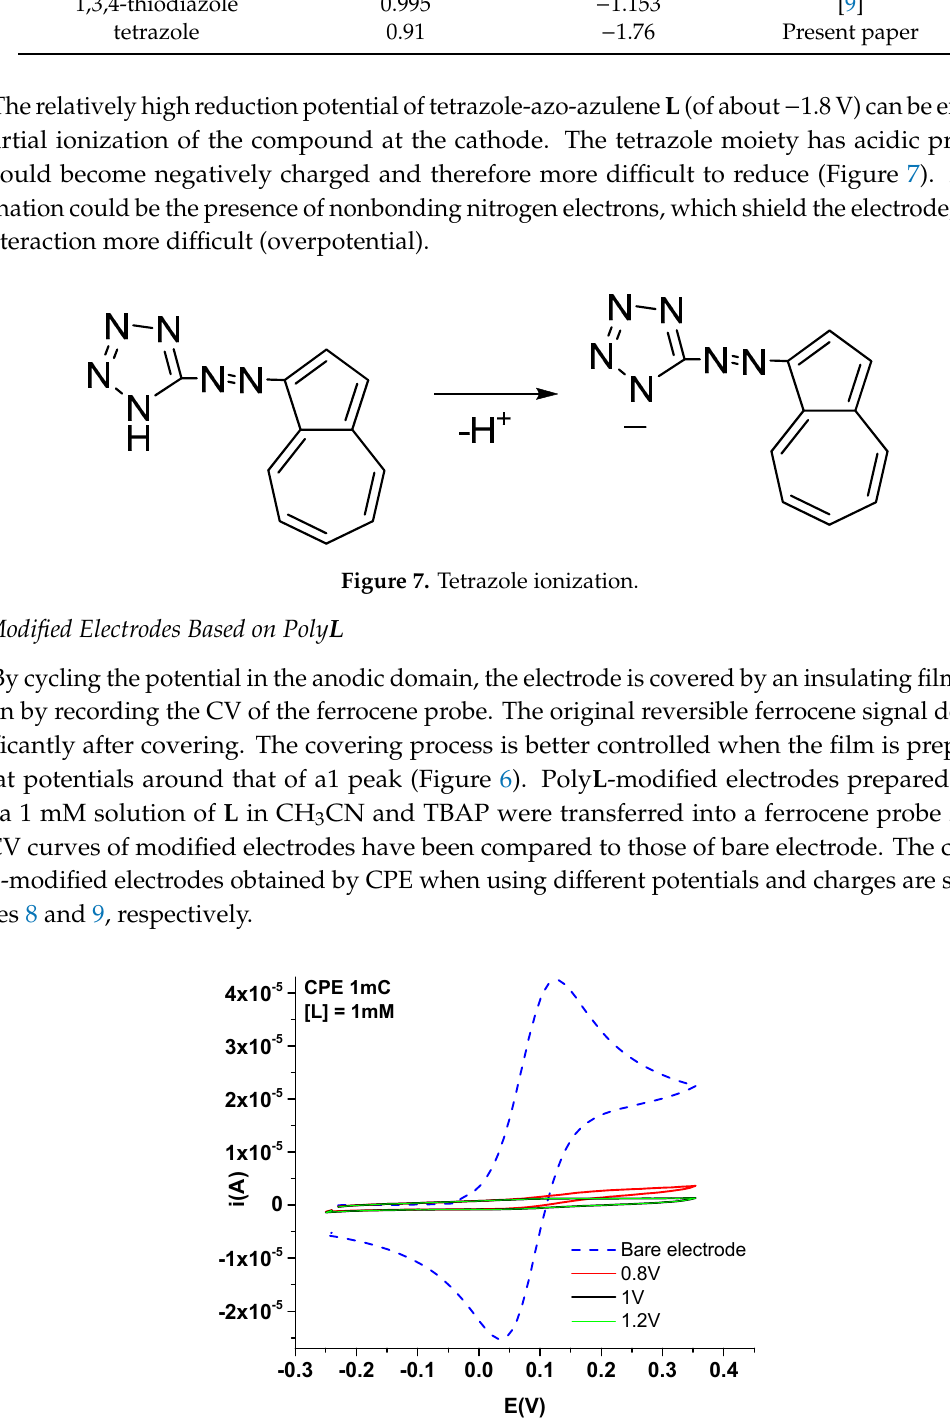
Figure 8. CV (0.1 V / s) curves in 1 mM ferrocene for poly L -modified electrodes prepared by CPE at Figure 8. CV (0.1 V/s) curves in 1 mM ferrocene for poly L ‐ modified electrodes prepared by CPE at + 0.8, + 1 and + 1.2 V in L solution (1 mM) using the electropolymerization charge of 1 +0.8, +1 and +1.2 V in L solution (1 mM) using the electropolymerization charge of 1 mC.